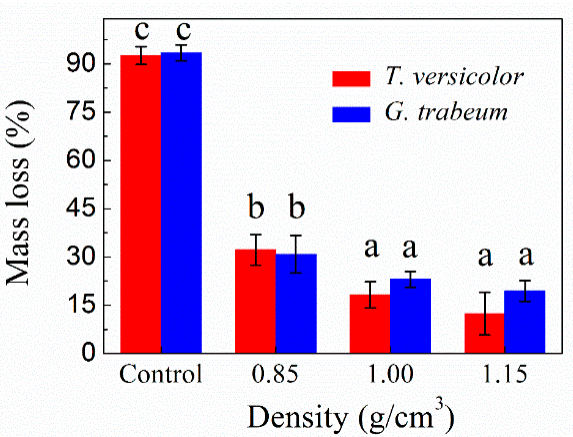
Figure 4. Mass loss of wood reference samples (control) and OWMEC samples with different densities after 12 weeks incubation with T. versicolor and G. trabeum fungi. For each sample, value bars with the same letter (a, b, c) indicate no significant difference at the 0.05 level. Error bars represent the standard deviation.